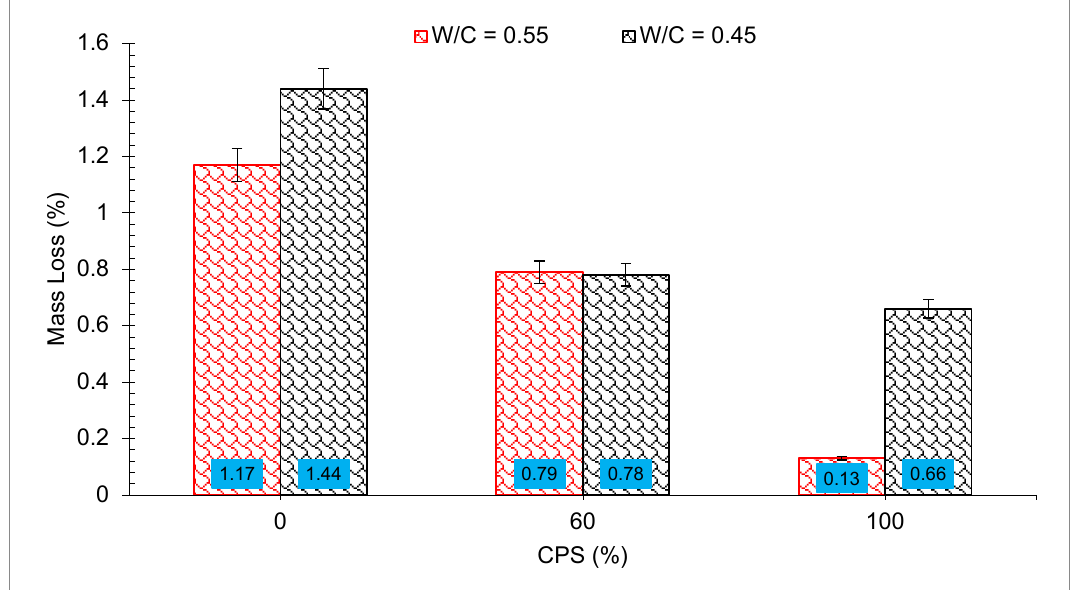
Figure 17. Corrosion test results: data source [47].